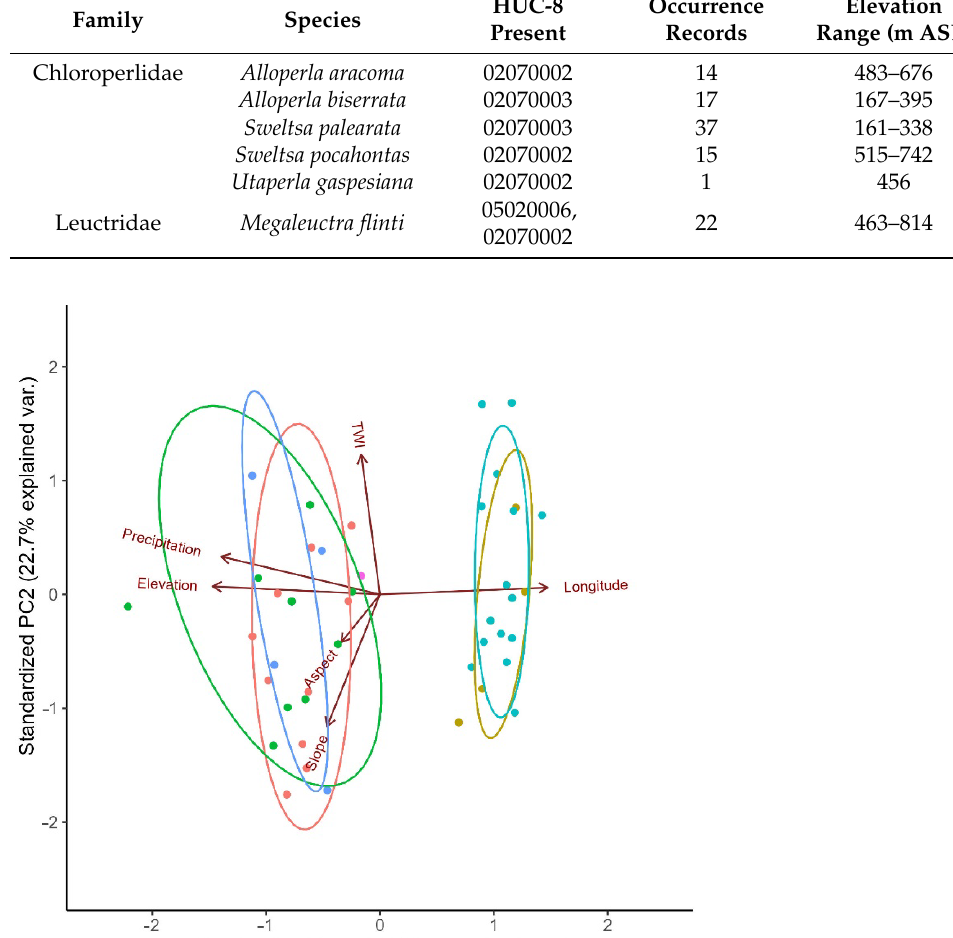
Figure 16. Principal Component Analysis (PCA) of Maryland’s listed Species of Greatest Conservation Need stoneflies with ordination of topographic and climatic variables. Percentage of variation that each PCA axis explains accompanies the x- and y-axes.